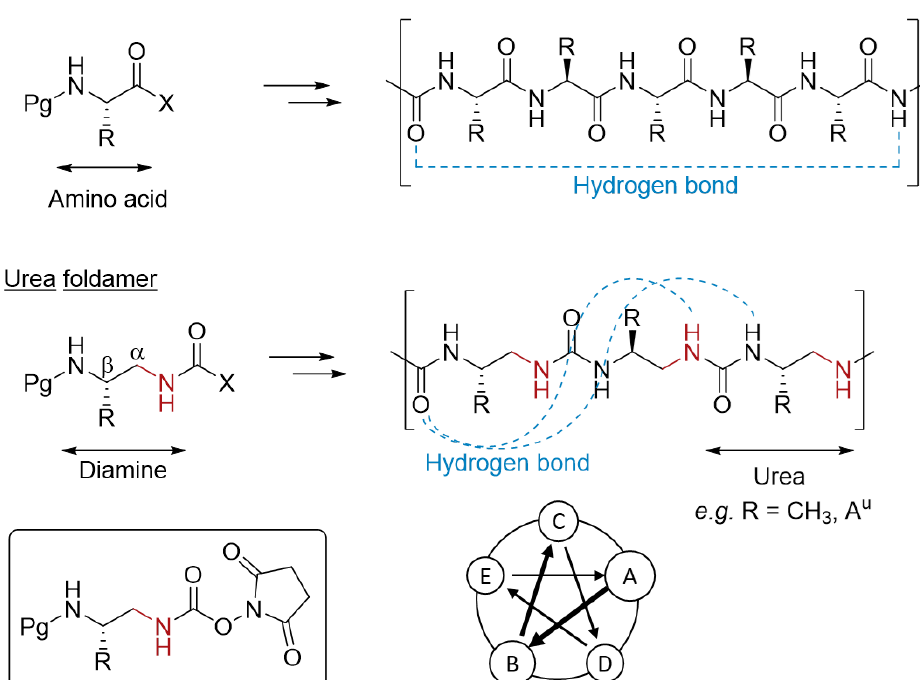
Figure 2. Comparison of the α -peptide and urea foldamer.